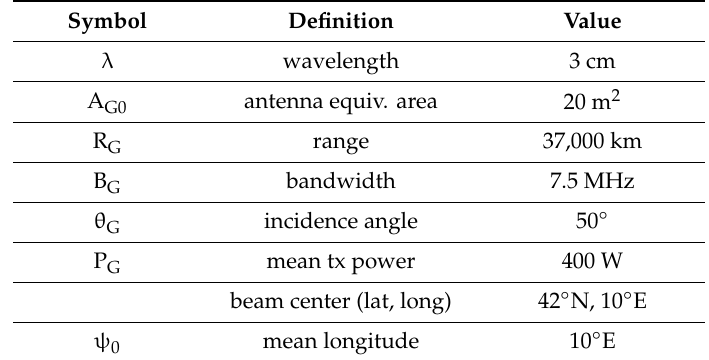
Table 2. Parameters for the X-band GEO-SAR.